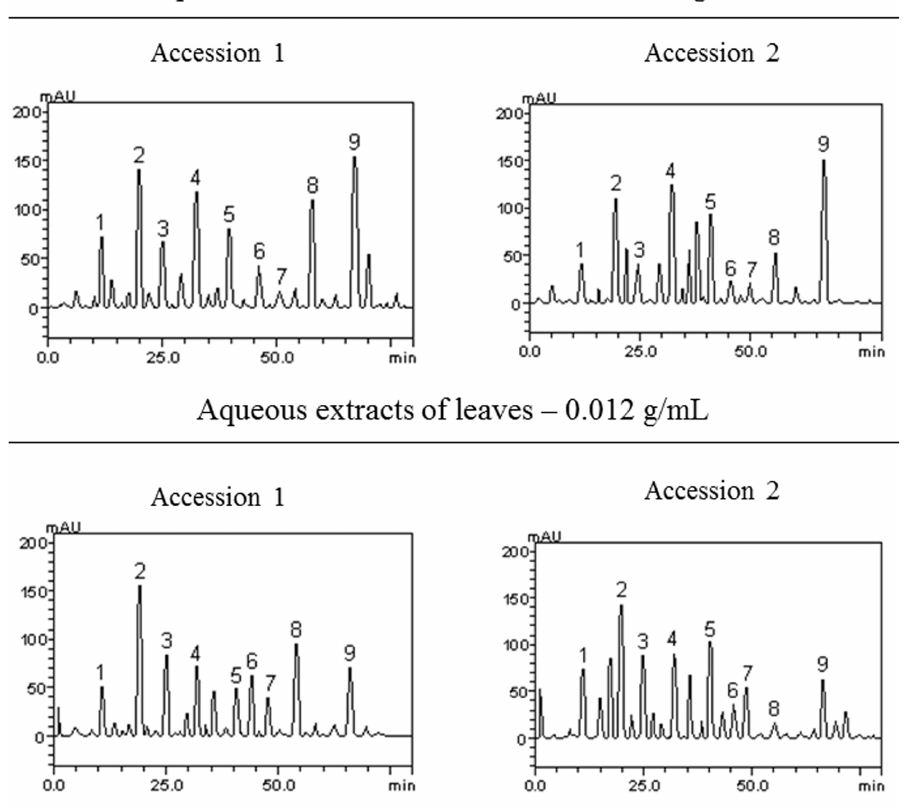
Figure 2 - Representative high performance liquid chromatography profile of Sambucus australis inflorescences (accession 1 and accession 2) and leaves (accession 1 and accession 2). Gallic acid (peak 1), chlorogenic acid (peak 2), caffeic acid (peak 3), ellagic acid (peak 4), rutin (peak 5), quercitrin (peak 6), isoquercitrin (peak 7), quercetin (peak 8) and kaempferol (peak